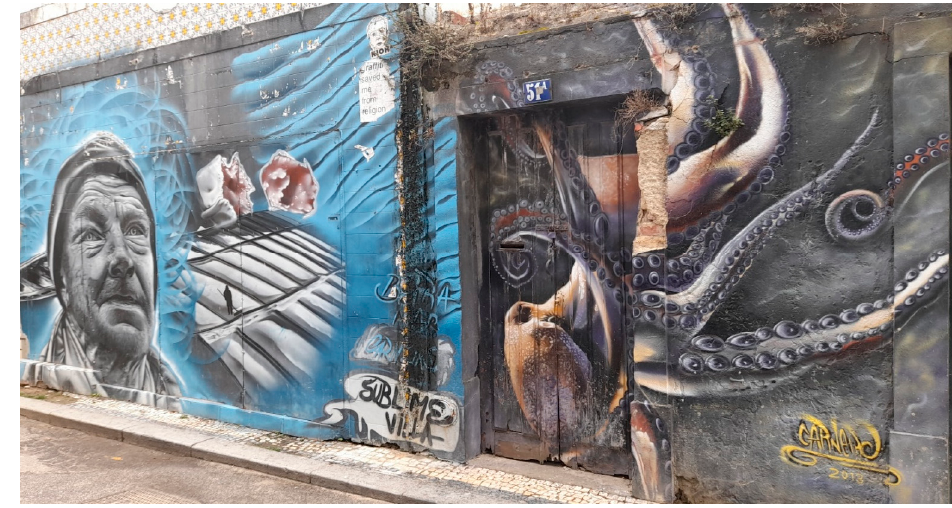
Figure 6. Tribute to fishermen, by F á bio Carneiro, 2013 (Source: author’s own photos, 2022).